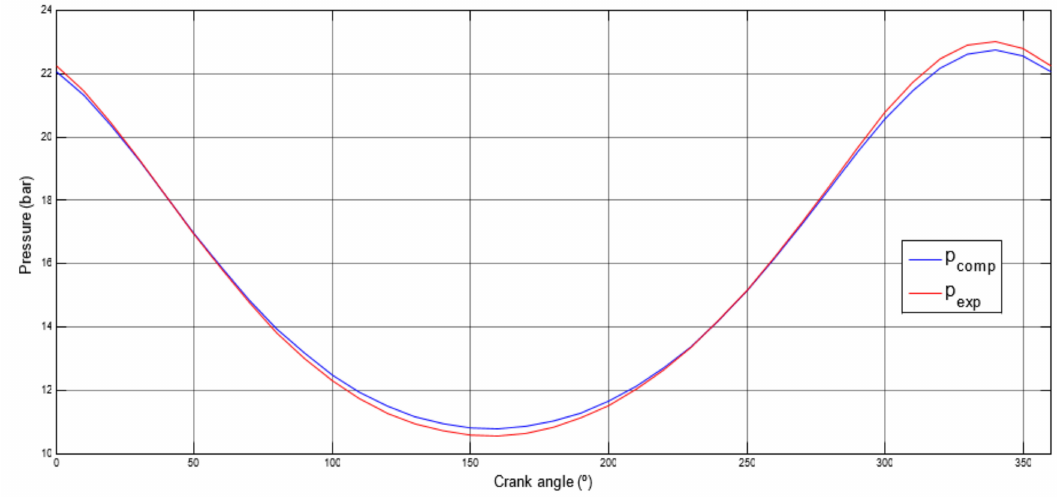
Figure 19. Pressure distribution in workspaces.